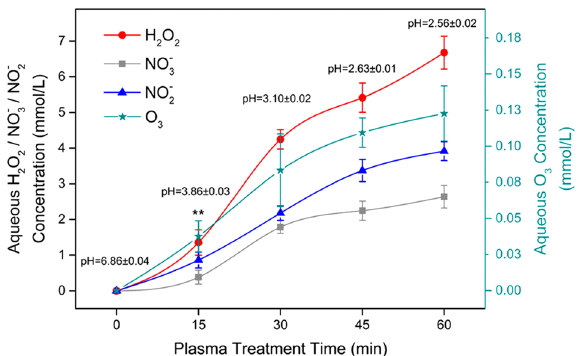
Fig. 3 Concentrations of four kinds of representative, long ‐ lived aqueous reactive species (RS; H 2 O 2 , NO 3 − , NO 2 − and O 3 ) in plasma ‐ activated water induced by the air plasma. Each point represents the mean of nine values ± standard deviation. The signi fi cance level *** p < 0.001 for each RS concentration at every plasma inducement time, except for H 2 O 2 at the plasma inducement time of 15 min (** p < 0.01). Reprinted with permission from ref. 57